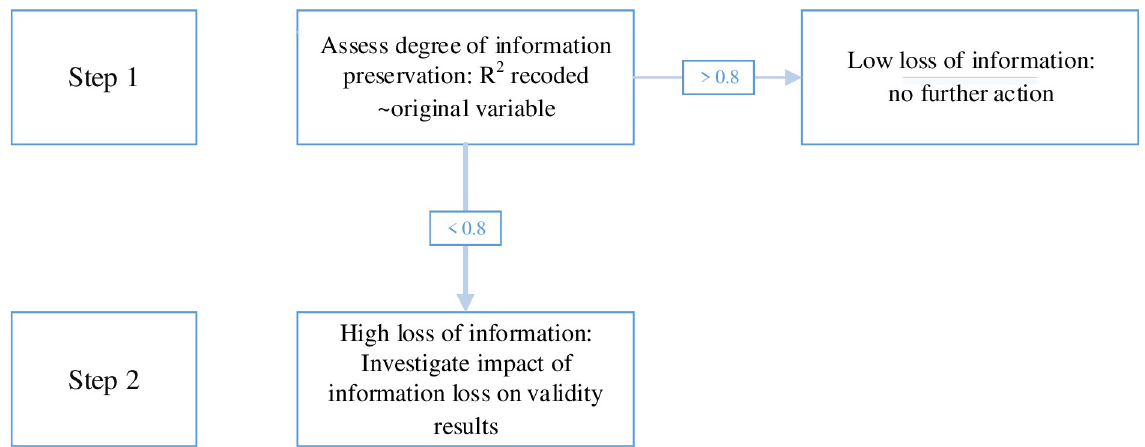
Fig 1. Flowchart of step 1 and step 2